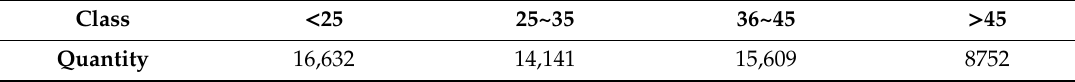
Figure 8. Examples from the Morph face database. Table 6. Age ranges in the Morph database.